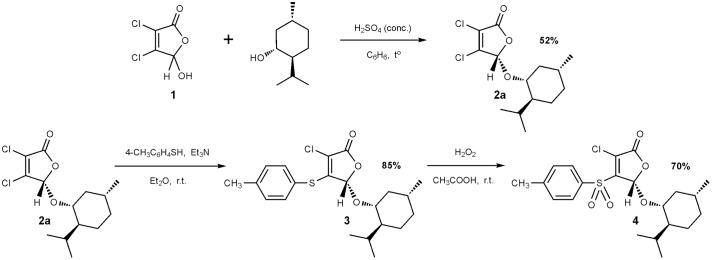
Synthesis of 2(5H)-furanone derivative F105.